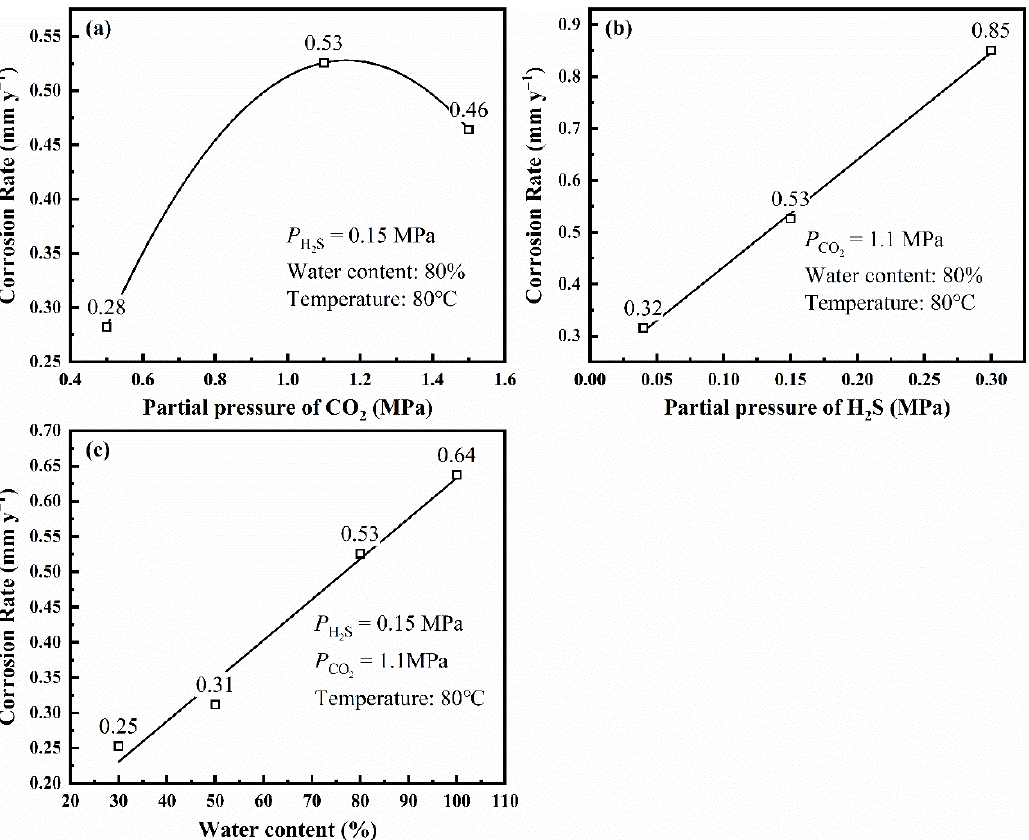
Figure 5. Corrosion rate of L80 steel without preloading stress obtained from immersion test under different partial pressure of CO 2 ( a ), different partial pressure of H 2 S ( b ), and different water content ( c ).